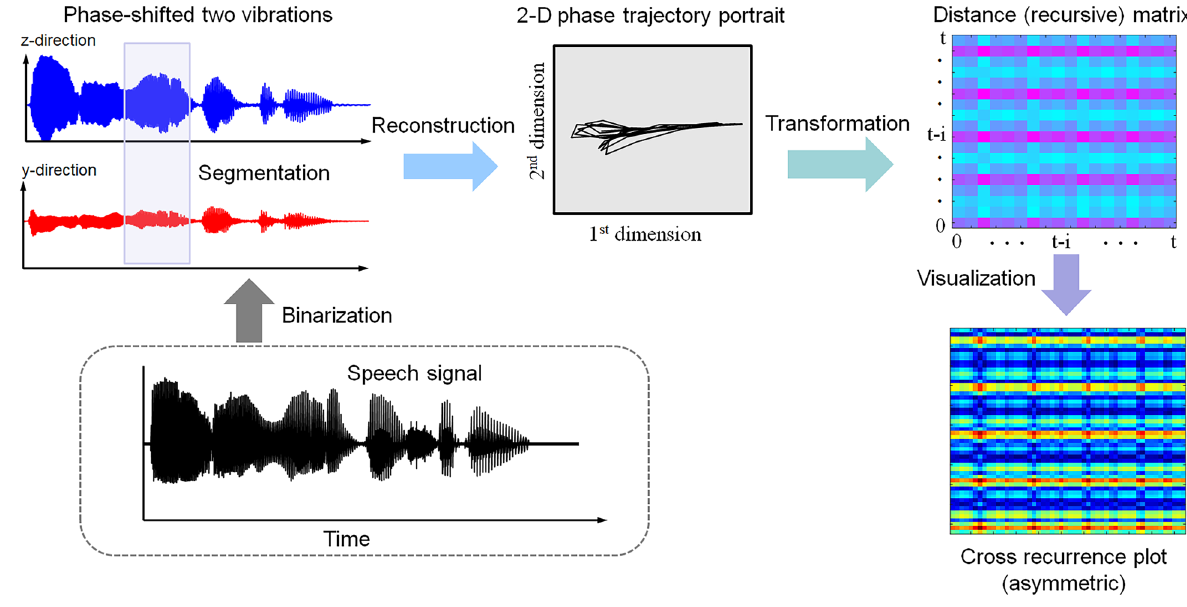
Figure 7. Input image generation framework based on CRP.